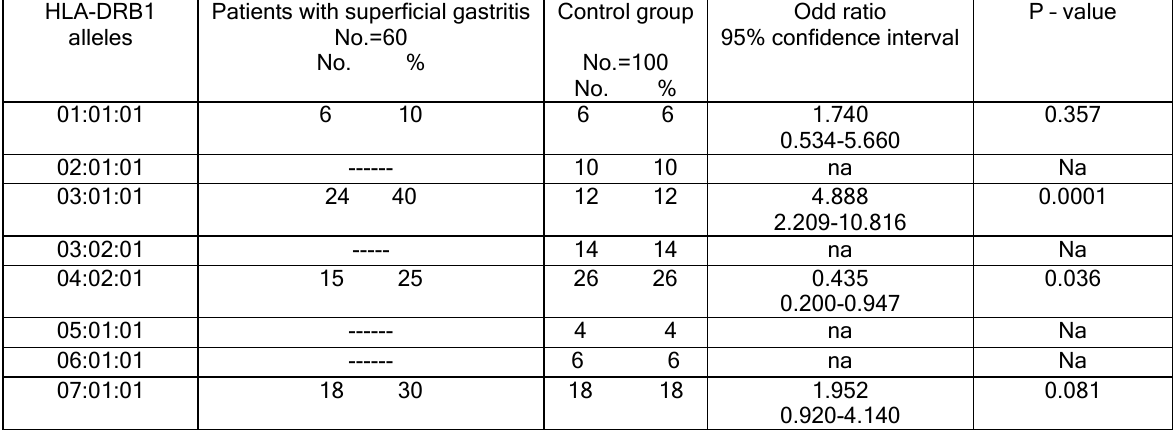
Table-4- Frequencies of HLA-DRB1 alleles in patients with superficial gastritis disease compared with control group. HLA-DRB1